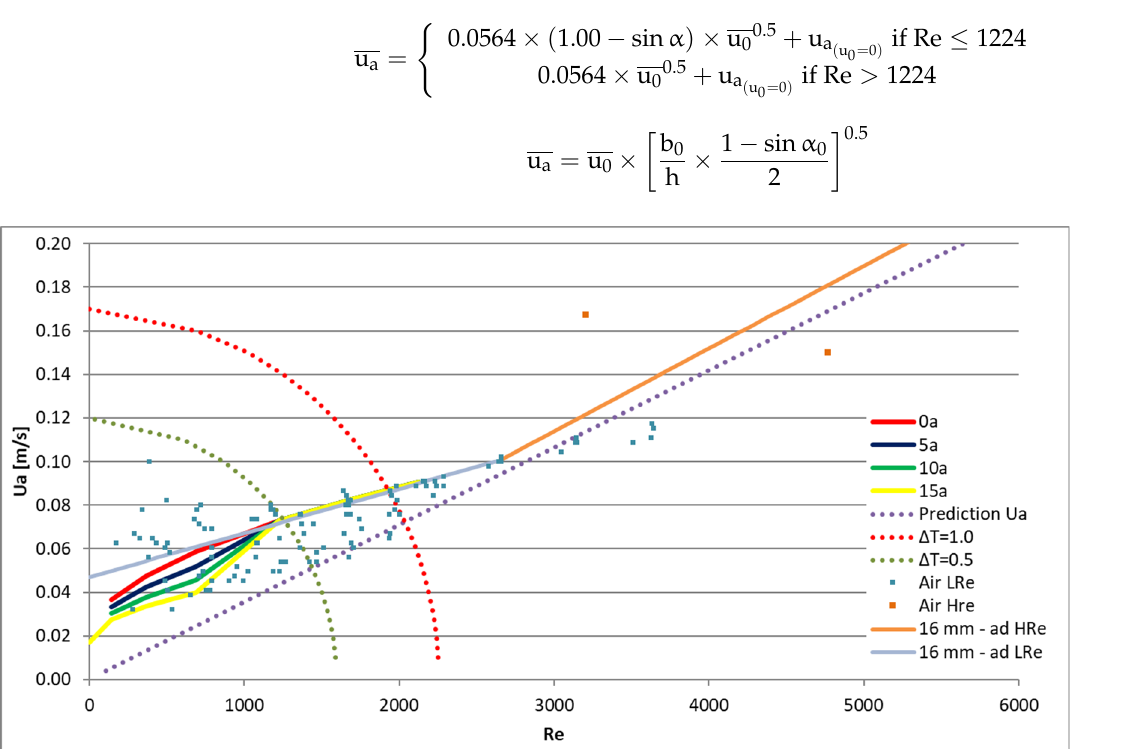
Figure 18. Comparison of the predictions of Equations (4)–(6), (9) and (10) with the test results.